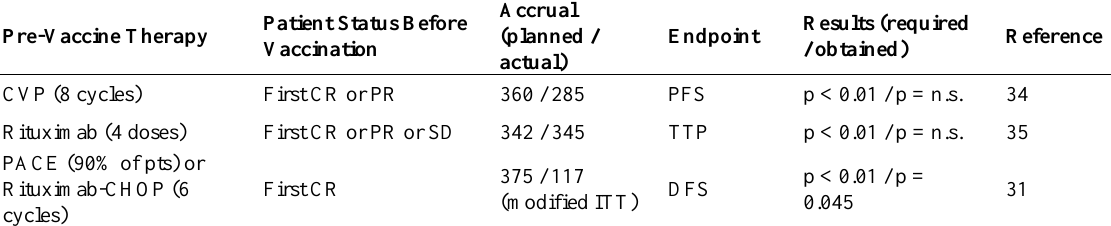
Table 3. Main features of all randomized clinical trials on idiotypic vaccination.